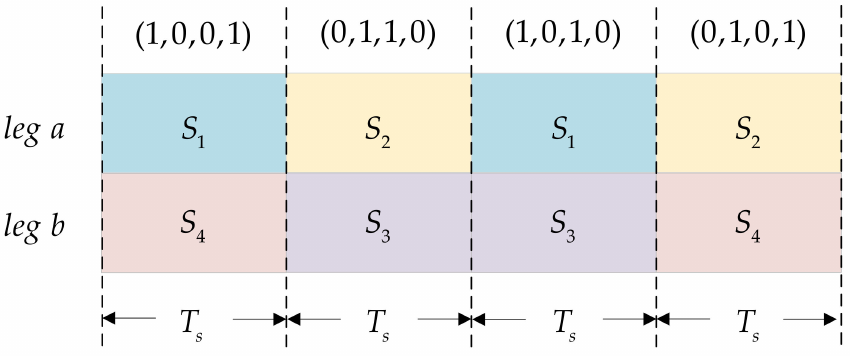
Figure 2. Possible switching vectors of